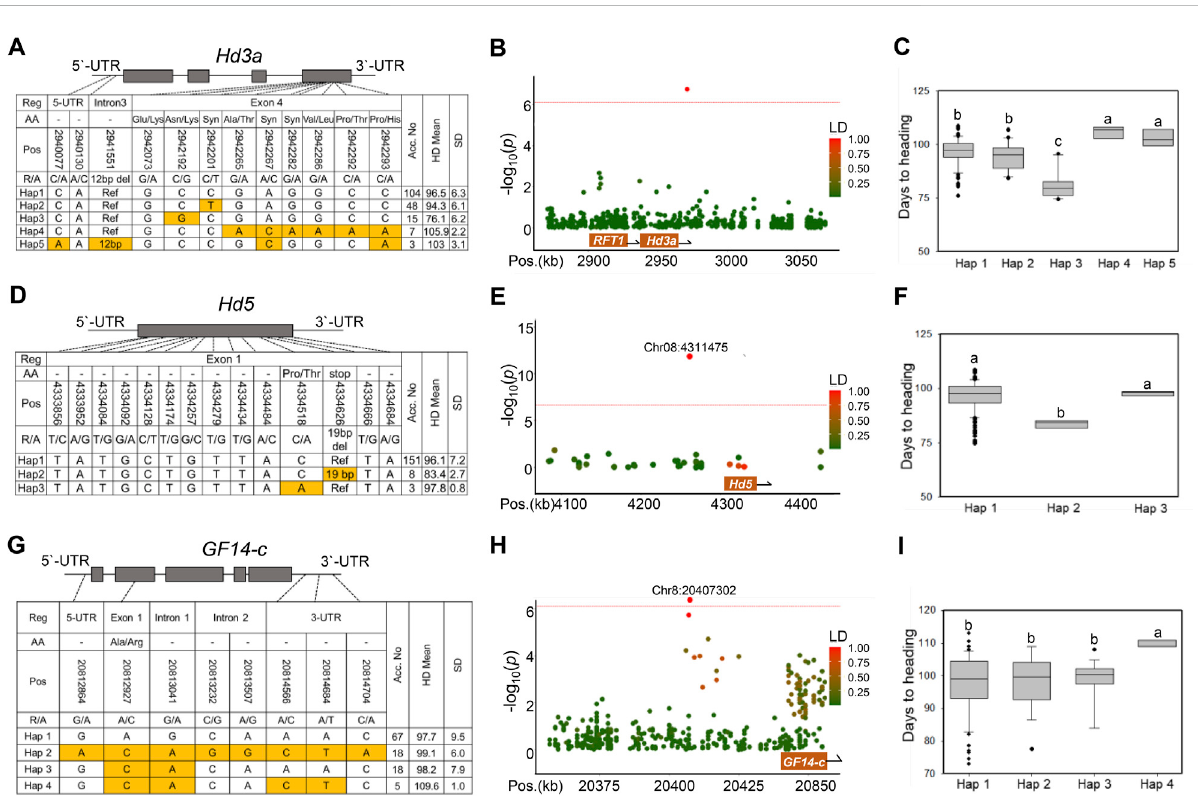
FIGURE 3 HaplotypeanalysisofthethreeknownHdgenes( Hd3a , Hd5, and GF14-c )detectedbyGWAS. (A) Genestructureandhaplotypeanalysisof Hd3a based on 11 signi fi cant SNPs and one InDel. A schematic diagram of Hd3a is shown on the top. (B) The LD plot shows association loci for Hd3a on chromosome 6. The color of each SNP indicates the r 2 value for the correlation with the lead SNP. Red and green color intensities indicate stronger and weaker LD (0 – 1). (C) Phenotypic variation of the fi ve haplotypes for Hd3a . (D) Three haplotypes were detected in Hd5 in CDS regions. (E) TheLDplotshowsassociationlocifor Hd5 onchromosome8. (F) Phenotypic variation ofthethreehaplotypesfor Hd5. (G) Haplotypeanalysis ofthe peak associated with the GF14-c gene. (H) The LD plot shows association loci for GF14-c on chromosome 8. (I) Phenotypic variation of the four haplotypes for GF14-c. Different letters indicate signi fi cant differences according to one-way ANOVA and Duncan ’ s least signi fi cant range test ( p <